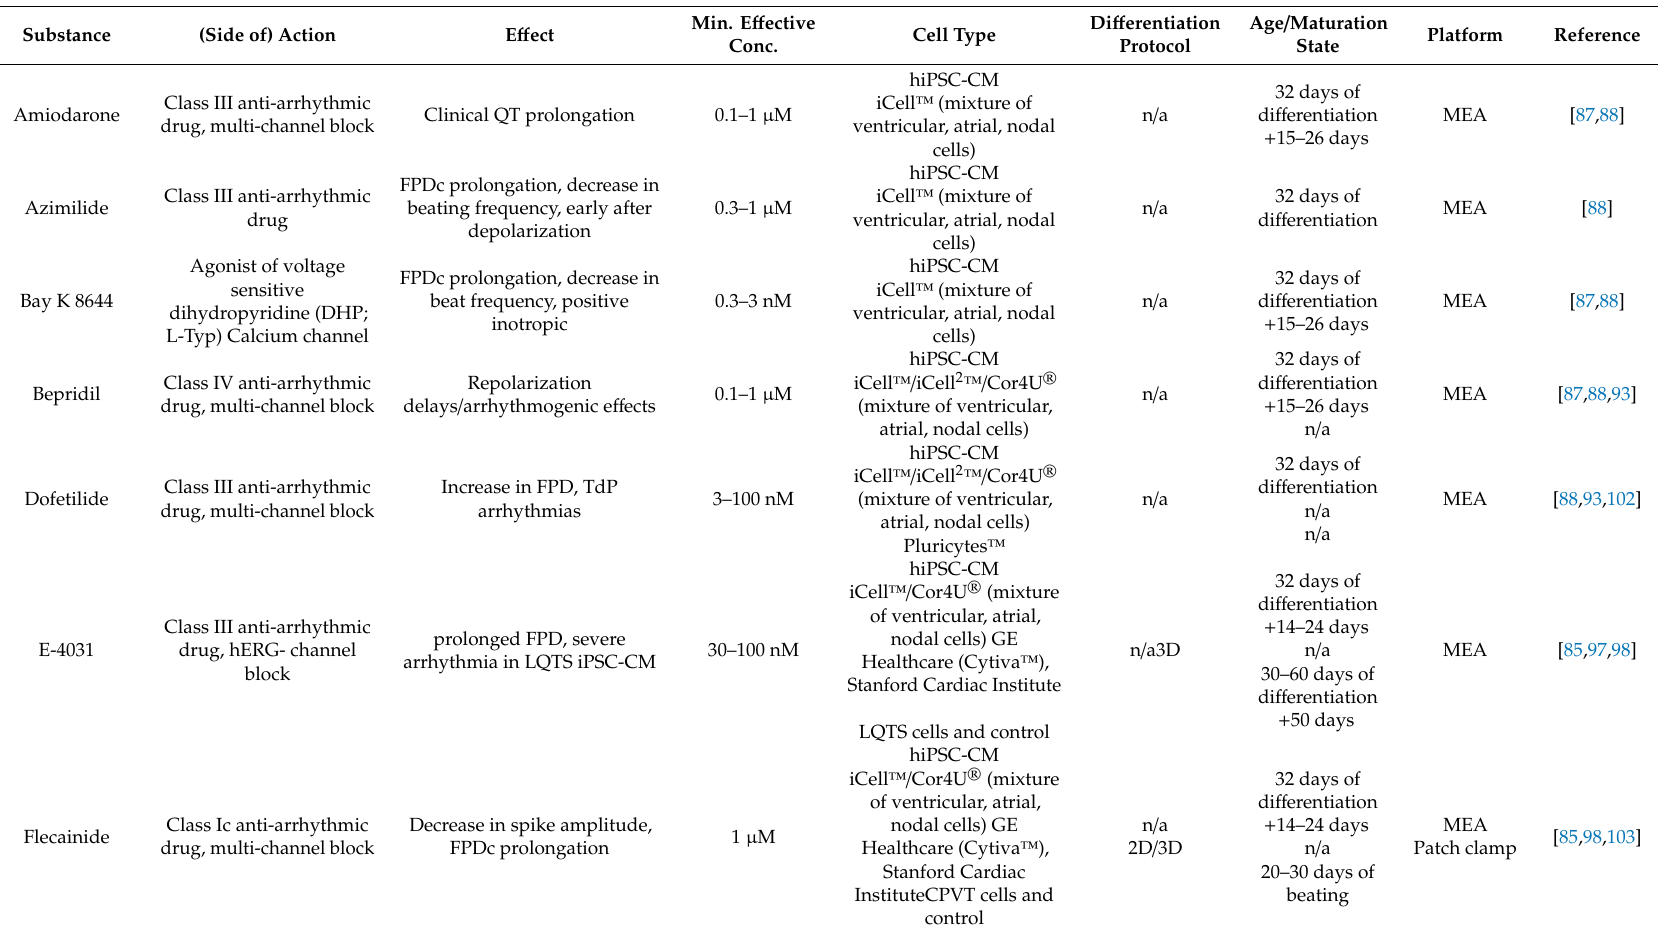
Table 4. MEA based safety testing of drugs with cardiac indication using